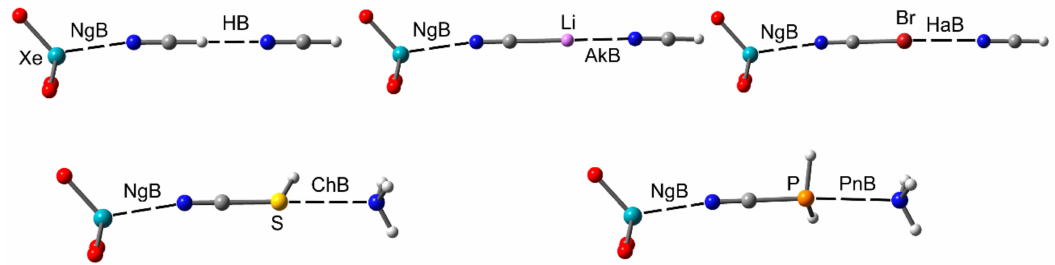
Figure 9. Ternary systems used by Esrafili et al. [107–109] to study the cooperativity e ff ect between noble gas (or aerogen) bond (NgBs) and AkB, HaB, ChB, and PnB interactions using XeO 3 as an NgB